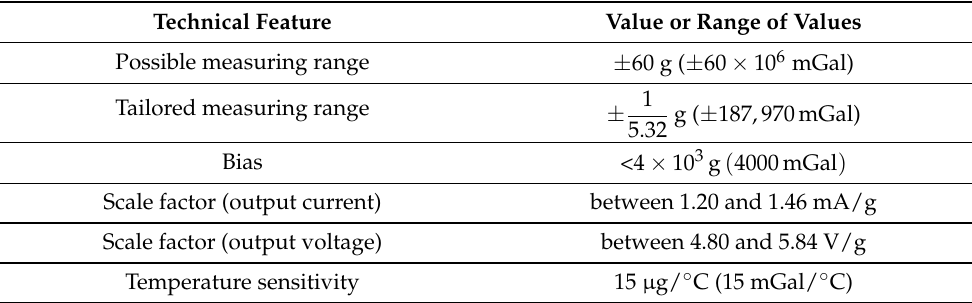
Figure 2. View of IFREMER’s AUV Aster x . This submersible is 4.5 m long, 2.1 m wide (fins included) and 0.71 m in diameter with a total mass of 850 kg. It is powered by 50V/16kWh Li-ion batteries. Its autonomy is about 16 h. The maximum immersion depth of Aster x is 2650 m. Table 1. Technical data of QFLEX QA-3000 electrostatic accelerometers. The letter “g” stands for an acceleration of 10 ms − 2 , that is 10 6 mGal. The possible measuring range of the accelerometers has been deliberately narrowed so as to lessen the digitizing error. A voltage offset has therefore to be applied to the accelerometer of each triad, the sensitive axis of which is most often in a direction close to the vertical. The electrical arrangement of the sensor only allows for specific force intensities below g/5.32 to be measured. Above this value, the accelerometers enter saturation plage. Therefore, the value of the limit tilt angle beyond which horizontal accelerometers enter saturation is 10.8 deg, value deduced from arcsin ( 1/5.32 ) . A voltage source that offers at least 5 µ V accuracy is crucial since a variation of such a value would be interpreted as a 1 mGal variation of the